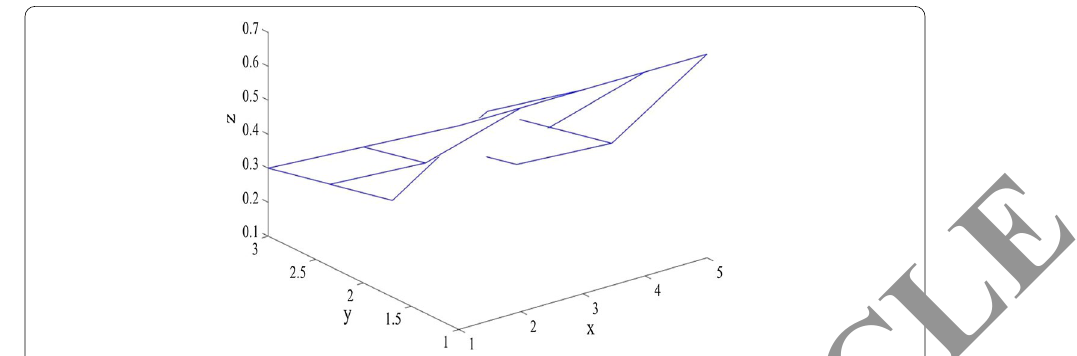
Fig. 3 Three-dimensional animation of arm